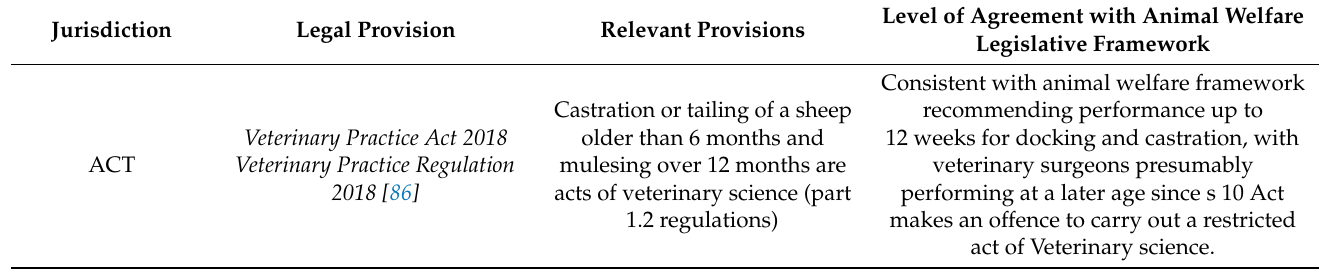
Table 5. Veterinary legislative framework across the states and territories with respect to marking